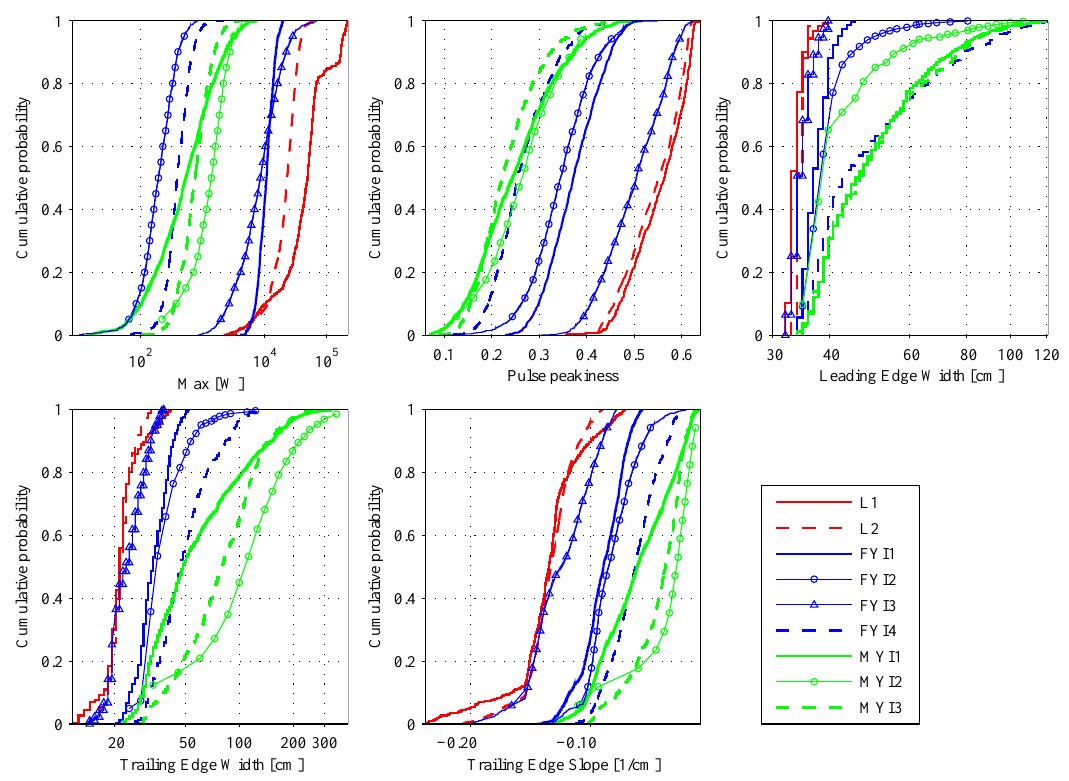
Fig. 5. Cumulative probability distributions for the nine cases (see Table 1) for the five waveform parameters: Max, PP, LeW, TeW and TeS. Fig. 5: Cumulative probability distributions for the nine cases (see table 1) for the five waveform Distributions obtained from waveforms resulting from leads are shown in red colors, from first-year ice in blue and multi-year ice in green parameters: Max, PP, LeW, TeW and TeS. Distributions obtained from waveforms resulting from colors. leads are shown in red colors, from first year ice in blue and multi year ice in green colors. Table 2. Mean distances between the empirical cumulative distri- bution functions of the five parameters determined from KS test: pulse peakiness (PP), trailing edge slope (TeS), leading edge width (LeW), trailing edge width (TeW), and the power maximum (Max). Leads vs. FYI vs. Leads vs. sea ice MYI flat